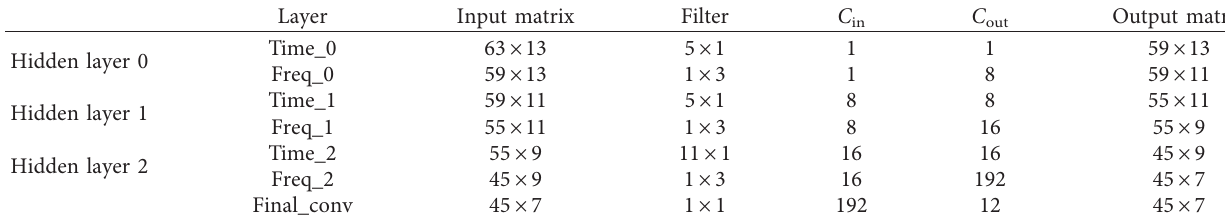
Figure 3: Convolutional layers: (a) classic CNN network and (b) SCNN network. Table 1: Convolutional parameters for the